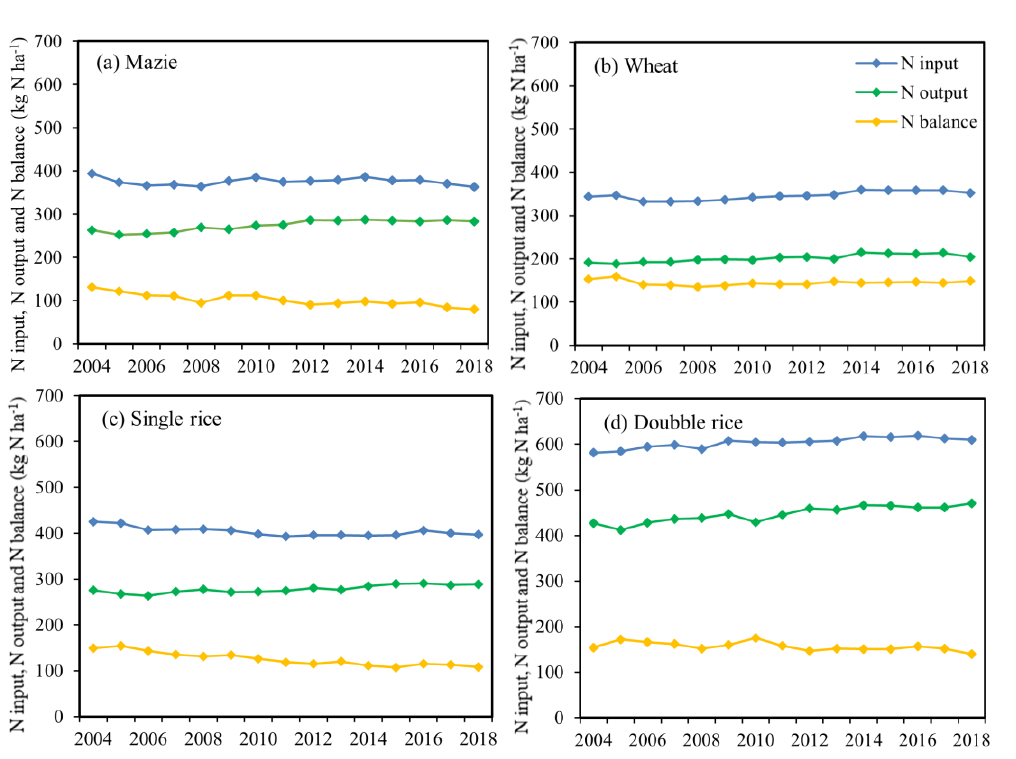
Figure 2. Nitrogen (N) input, N output and N balance per hectare (kg N ha − 1 ) from 2004 to 2018 for ( a ) maize, ( b ) wheat, ( c ) single rice, ( d ) double rice at national scale in China’s farmlands, respec- tively.